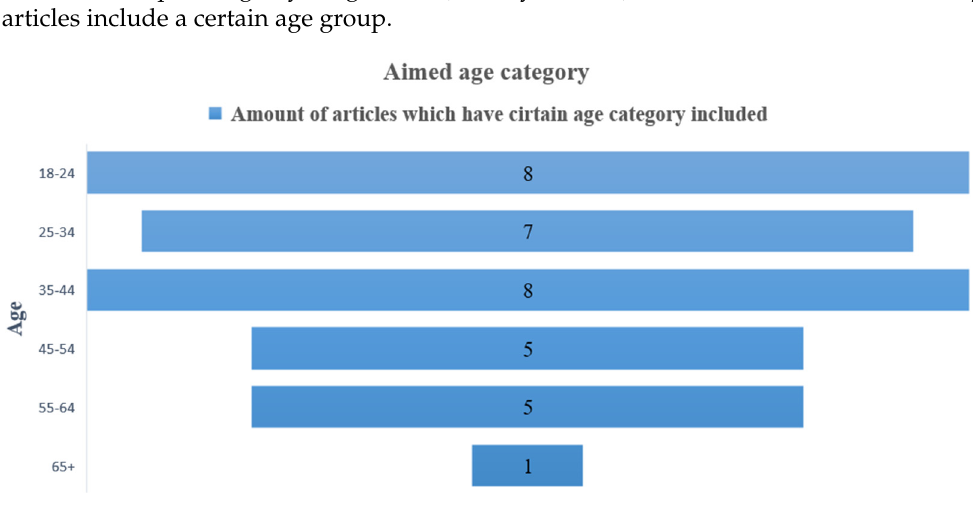
Figure 4. Aimed age category.